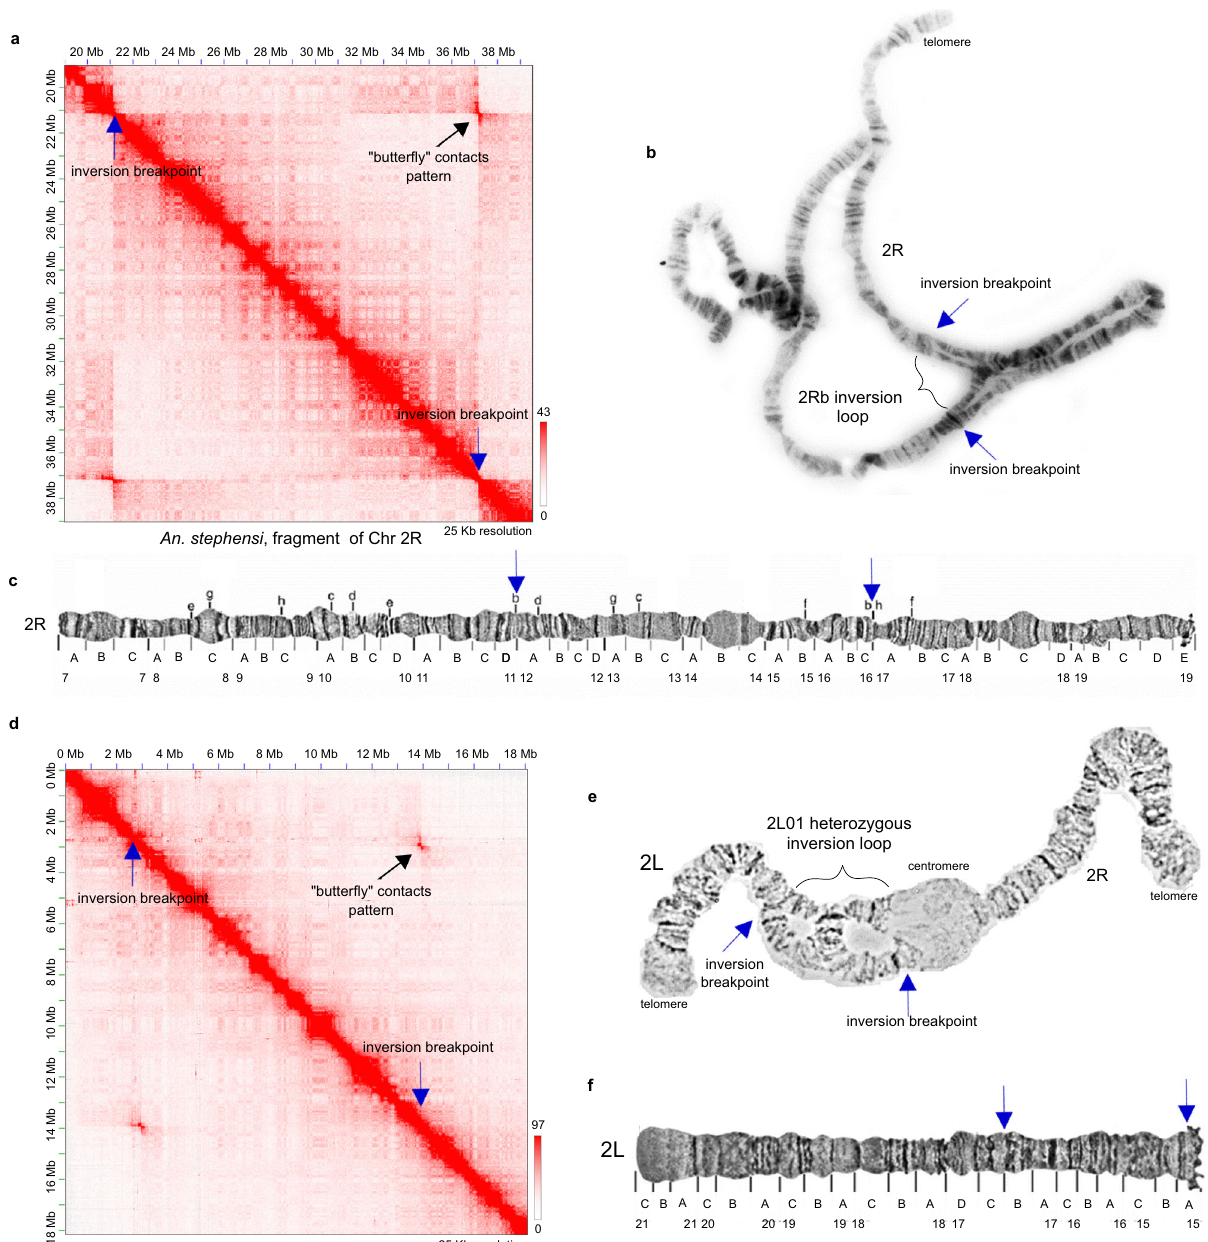
Fig. 3 Polymorphic inversions identi fi ed using Hi-C data. a Region of the An. stephensi Hi-C contact map with the 2Rb polymorphic inversion manifested as a clear “ butter fl y ” pattern, color bar re fl ects the contact frequency; b Light microscope image of An. stephensi polytene chromosomes showing the 2Rb inversion heterozygous loop; c The cytogenetic map of An. stephensi chromosome 2R, published previously in Jiang et al. 25 ; d Region of the An. atroparvus Hi-C contact map with the 2L1 polymorphic inversion, color bar re fl ects the contact frequency; e Light microscope image of An. atroparvus polytene chromosome 2 showing the 2L01 heterozygous inversion loop; f Physical map of An. atroparvus chromosome 2L, published previously in Artemov et al. 23 . Inversion breakpoints are shown with blue arrows in all (Supplementary Fig. 3). Strong centromere-centromere cluster- frequencies con fi rmed an increase of interactions between loci ing as well as inter-chromosomal and intra-chromosomal from different chromosome arms located equidistantly from the telomere – telomere interactions were detected. These contact centromeres (Supplementary Fig. 4). This increase of interac- patterns suggest a Rabl-like con fi guration 39 – 41 in Anopheles tions was more pronounced in embryonic tissues (1.49 – 2.45 genomes where centromeres and telomeres form clusters within times) than in adult mosquito data (1.19 – 1.25 times), suggesting the nuclear space (Fig. 4b). Additionally, we observed another that the Rabl-like con fi guration might be a feature of some but manifestation of the Rabl-like con fi guration represented not all cell types. 3D-FISH experiments on An. stephensi ovarian by interactions between chromosomal arms, which is seen tissue con fi rmed a tight clustering of the centromeric regions in as “ wings ” located perpendicular to the main diagonal on the follicle cells and the lack of such tight clustering in nurse cells Hi-C contact map (Fig. 4a). Quantitative analysis of contact within polytene chromosomes (Fig. 4c).